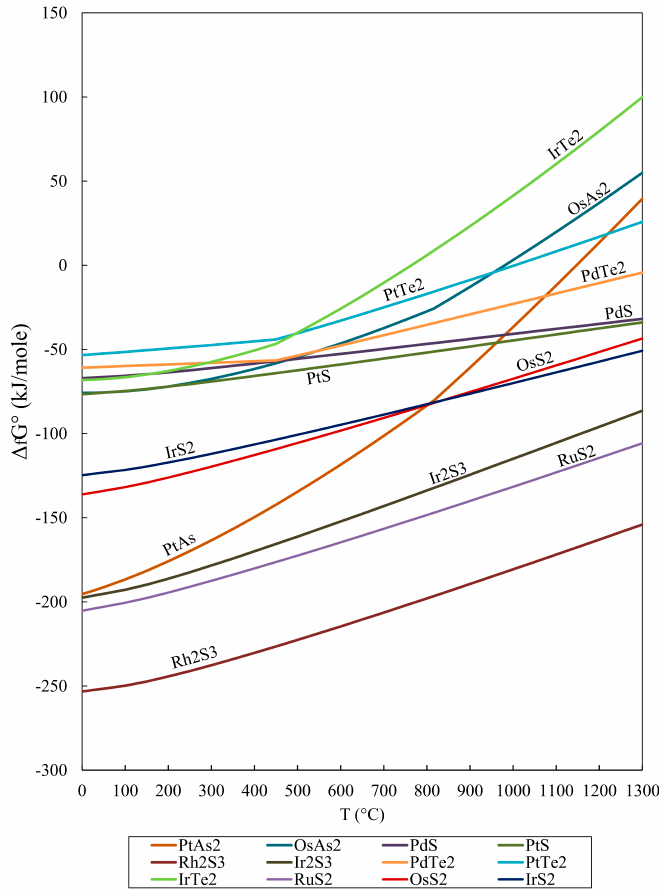
Figure 5. A comparative diagram plotting the free energy ( Δ f G°) against temperature. Data from Table 4.